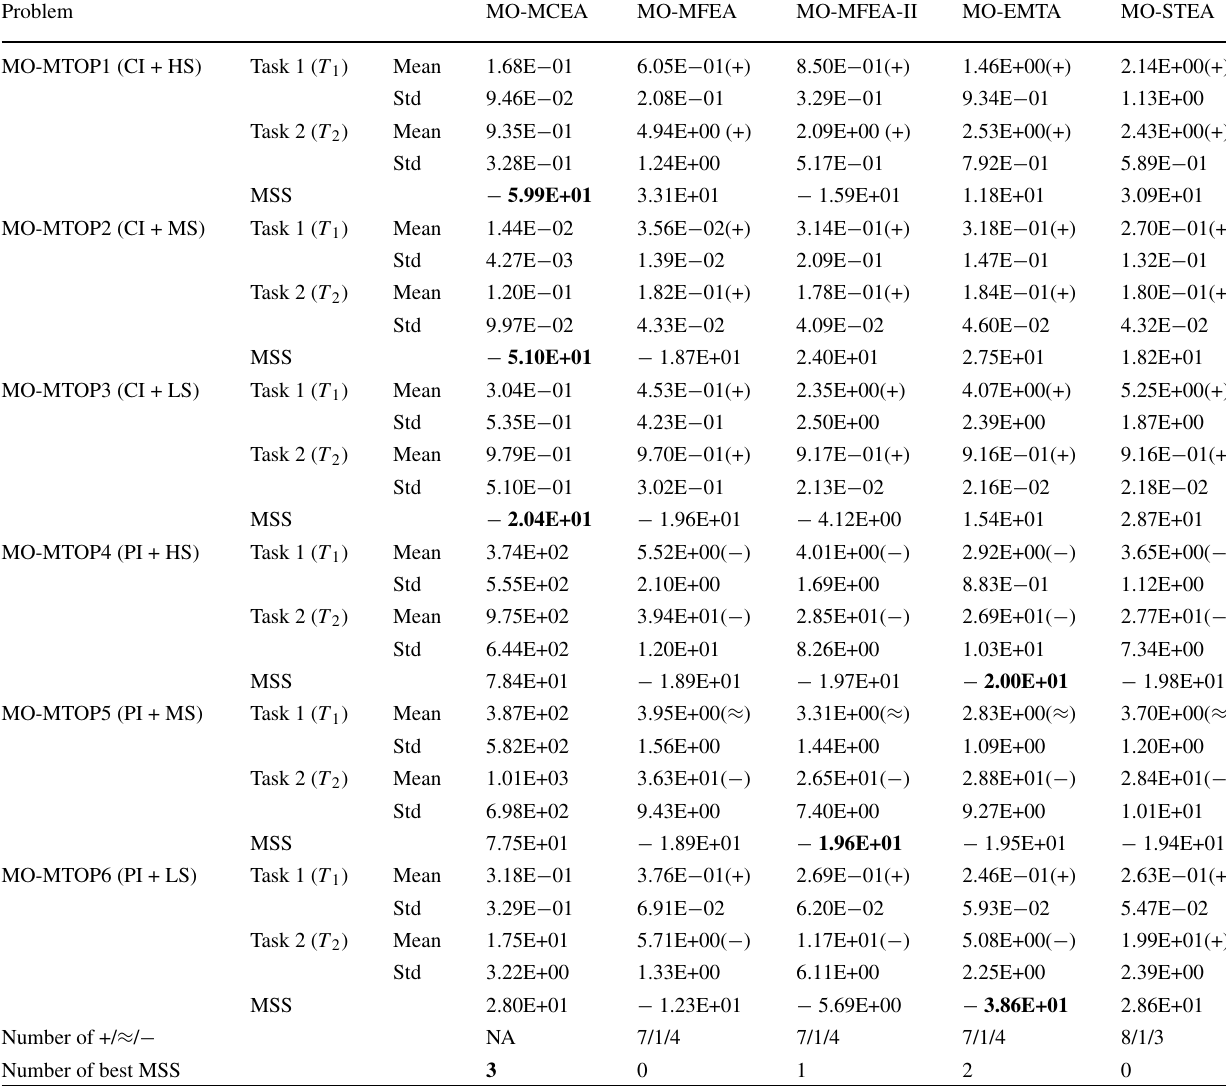
Table 2 Comparisons between the proposed MO-MCEA and state-of-the-art algorithms